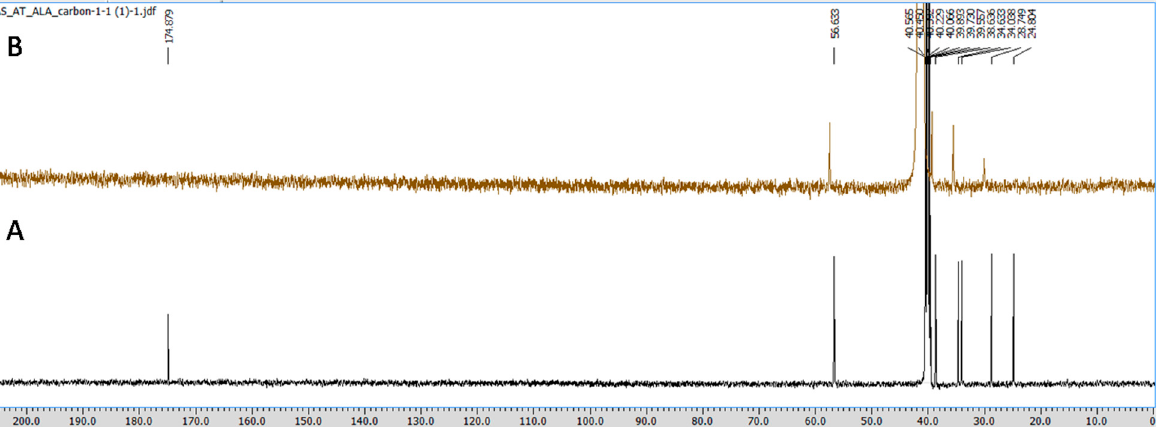
Figure 5. 13 C NMR of ( A ) ALA and ( B ) ALA with Cu after 5 min in DMSO- d 6 at 125 MHz. The carbonyl peak comes at 174.87 ppm in the 13 C NMR spectra of ALA, and after the addition of Cu, the peak vanished, indicating that the carbonyl group was involved in the metal chelation.